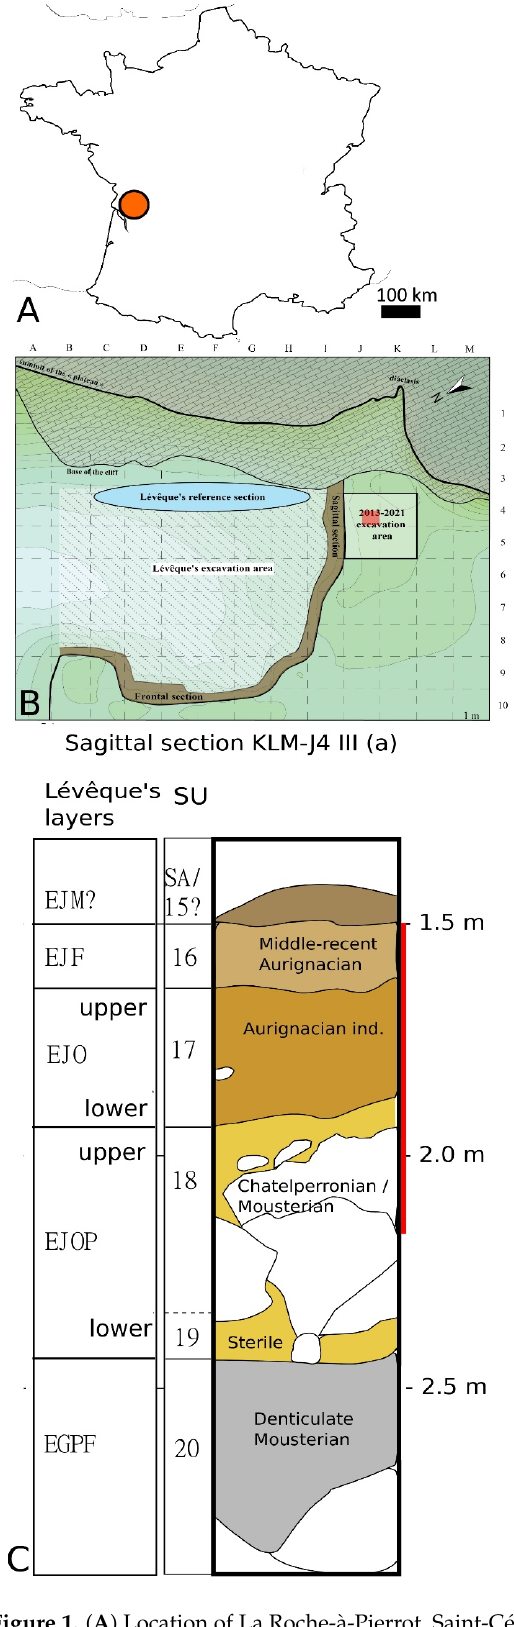
Figure 1. ( A ) Location of La Roche- à -Pierrot, Saint-C é saire (orange circle); ( B ) topographic plan with the excavation grid: the square on the right corresponds to the currently excavated area and the